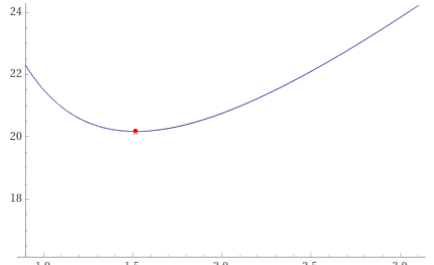
(cid:39) 20.1743 at λ (cid:39) ind